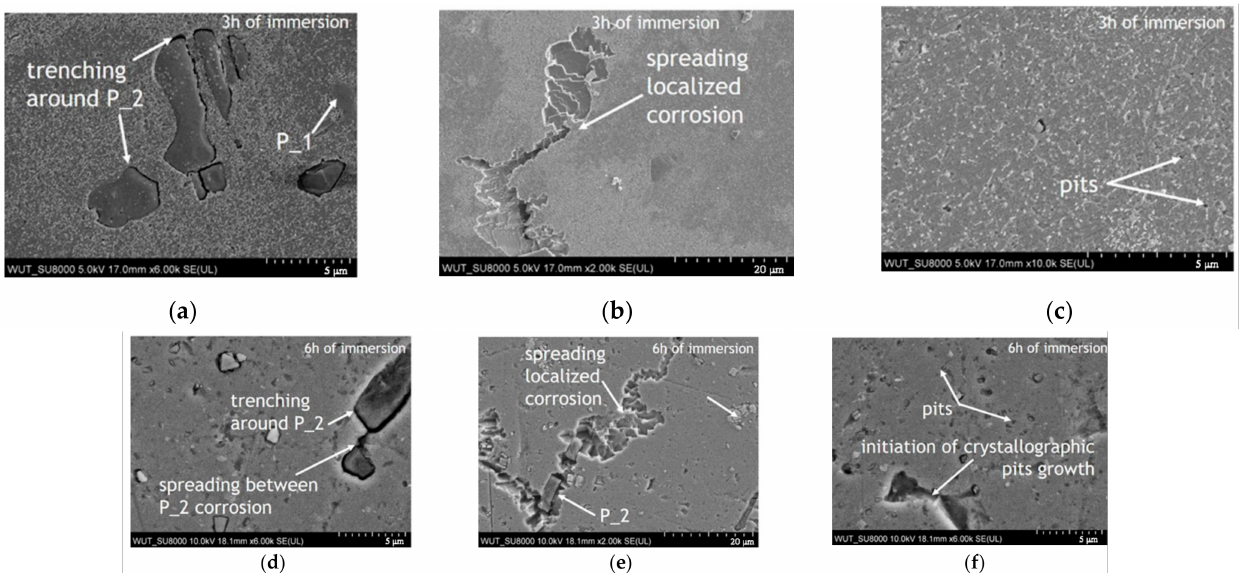
Figure 7. Post-corrosion observations of AA5754 in the undeformed area (A) after immersion under open-circuit conditions. Images taken after 3 h of immersion showing: ( a ), the propagation of crystallographically-grown pits, ( b ), trenching around Si-rich (P_2) particles, and ( c ) high-magnification image of tiny pits. Images taken after 6 h of immersion showing: ( d ), the propagation of crystallographically-grown pits, ( e ), trenching around Si-rich (P_2) particles, and ( f ) the formation of tiny pits.